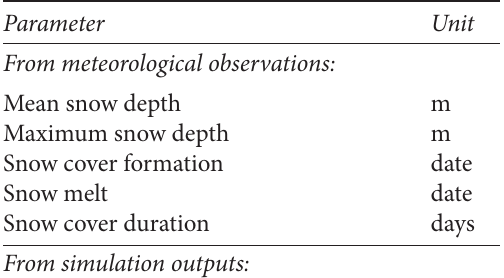
Table 1. Parameters listed from meteorological observa- tions and from simulation outputs in each of the study winters. Snow density above a 350 kg m -3 threshold was considered as icy and problematic for reindeer grazing (Vikhamar-Schuler et al.,